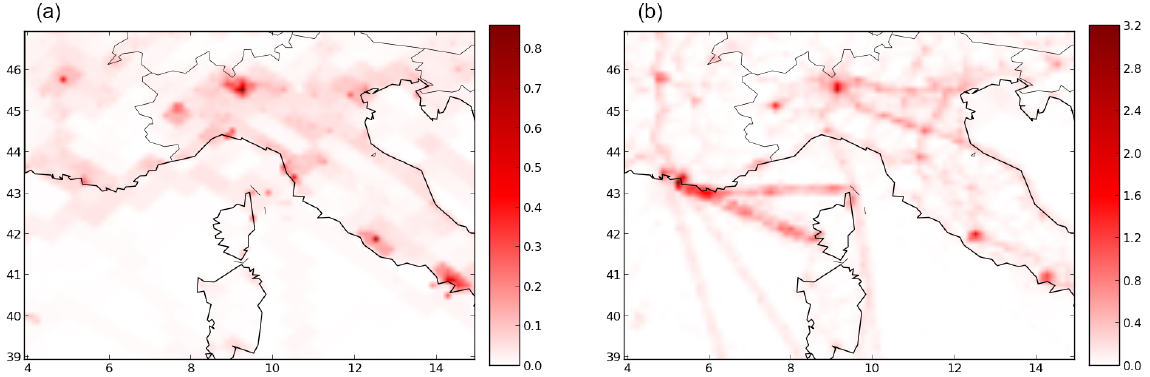
Figure 2. Average NO x emissions over the summer campaign 2013 from the EMEP emission inventory (a) , and absolute differences (µgm − 2 s − 1 ) of NO x emissions between HTAP and EMEP inventories (b) . The horizontal and vertical axes show longitude and latitude in degrees,